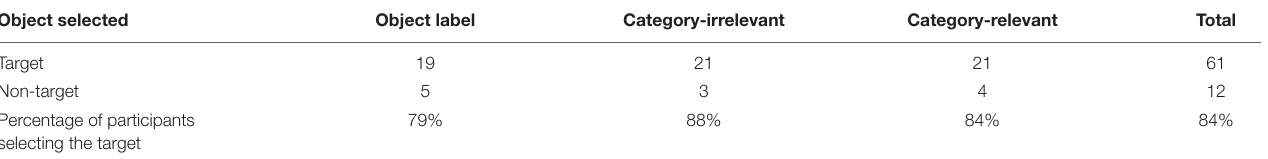
TABLE 1 | Comprehension Test: accuracy by condition.